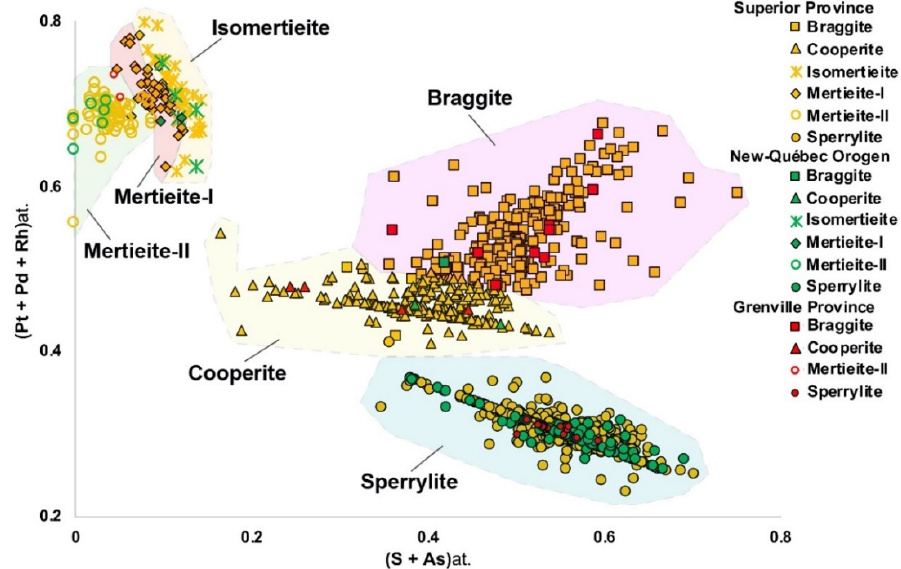
Figure 19. Covariation of (Pt at. + Pd at. + Rh at.) vs. (As at. + S at.) in the composition of relatively abundant platinum-group minerals (PGMs) including sperrylite, braggite, cooperite, isomertieite, mertieite-I, and mertieite-II recovered from till collected from different geological settings within the Canadian Shield. The elemental values are presented in atomic proportions (at.). Although regional differences are noted, most of these minerals show ubiquitous distributions.